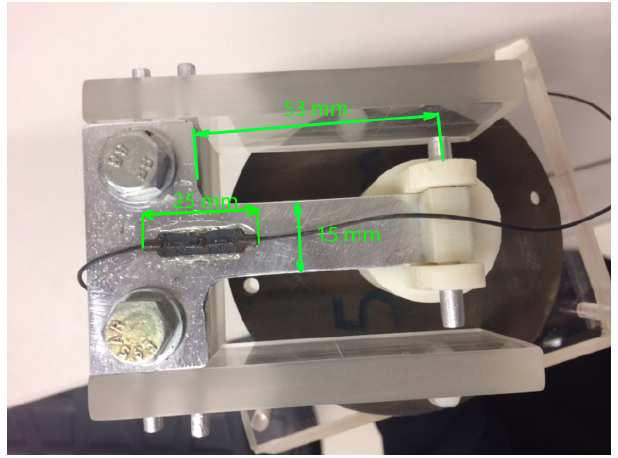
Figure 7. Optical strain sensor mounted on the beam of the sensor prototype.